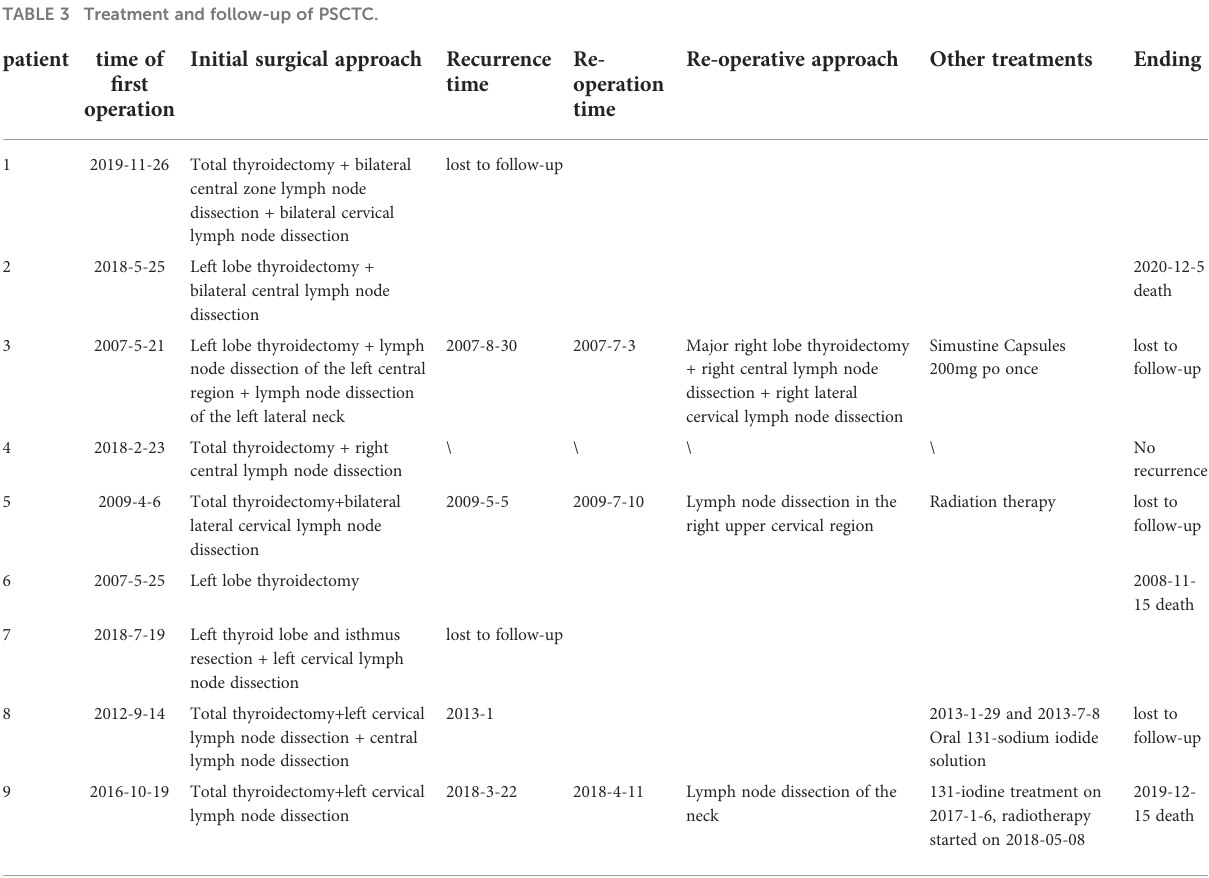
TABLE 3 Treatment and follow-up of